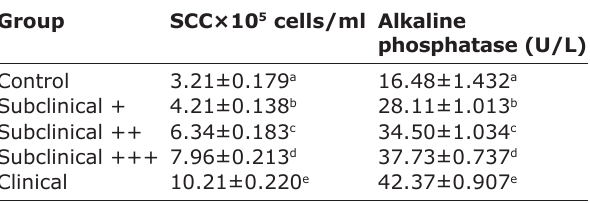
Table-1: SCC (10 5 cells/ml) and alkaline phosphatase (U/L) of milk from normal buffaloes and the buffaloes affected with subclinical and clinical